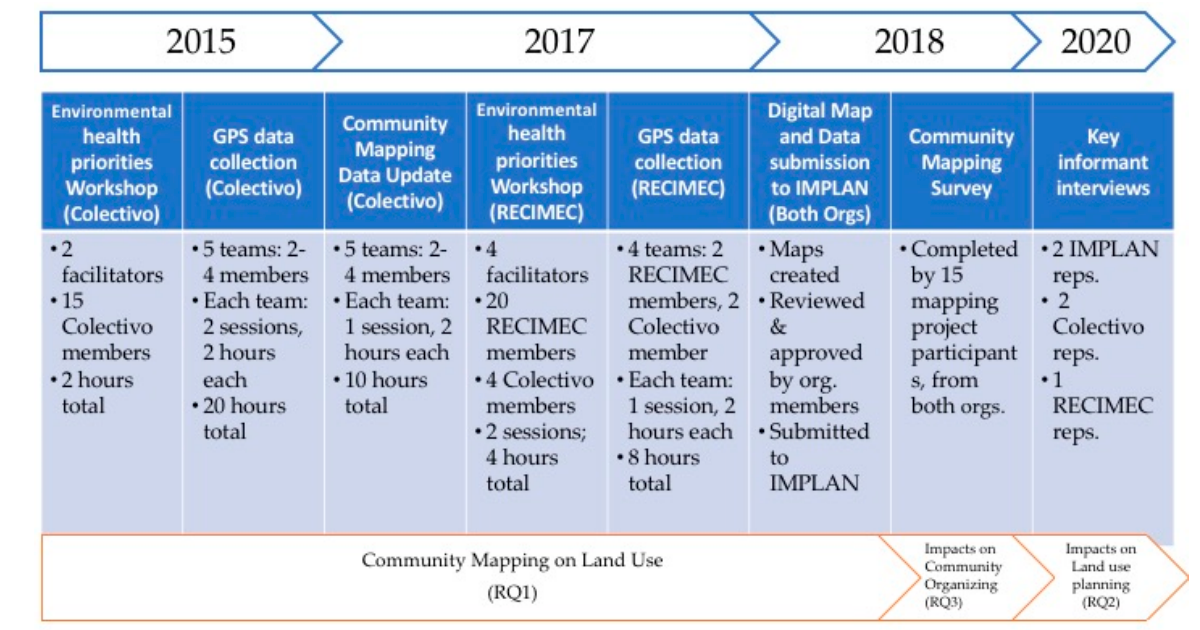
Figure 2. General community mapping workflow .